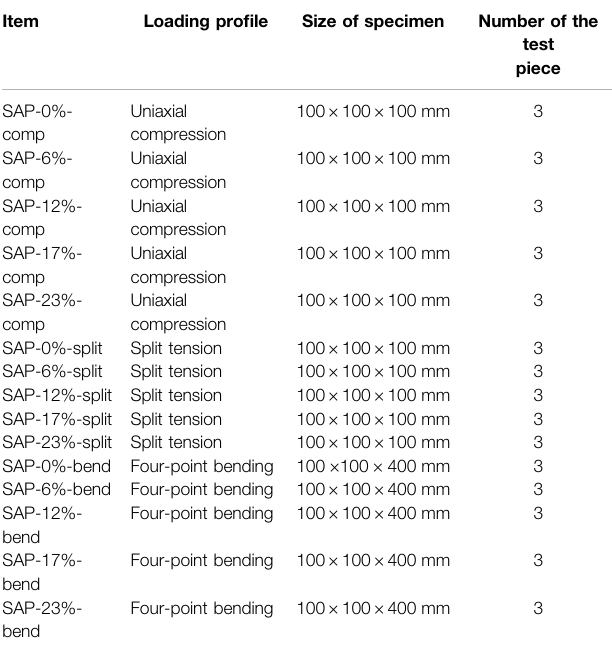
TABLE 3 | The load schemes in